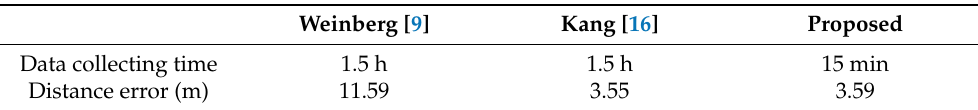
Table 4. Comparison of moving distance errors with other